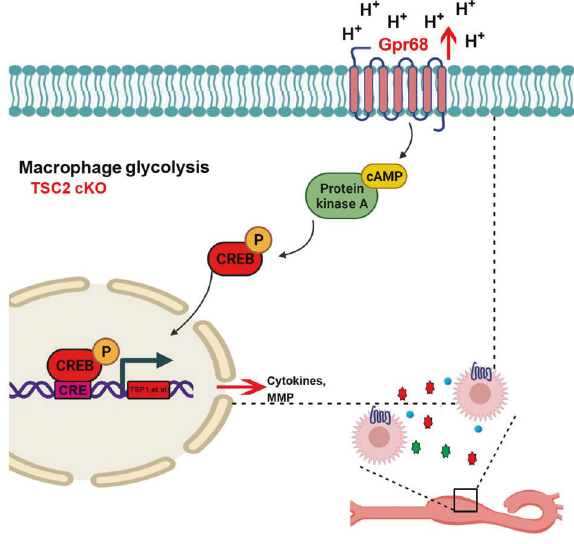
Fig. 8 Working schematic of how Tsc2 depletion in macrophage aggravated AngII-induced aortic aneurysms formation. Tsc2 depletion enhanced glycolytic activity and upregulated Gpr68 expression in macrophages, resulting in increased transcription activity of CREB. CREB acts on TSP-1, Mmp9 and FOS, aggravating the in fl ammatory response and elastin degradation, further promot- ing the formation of AAs.